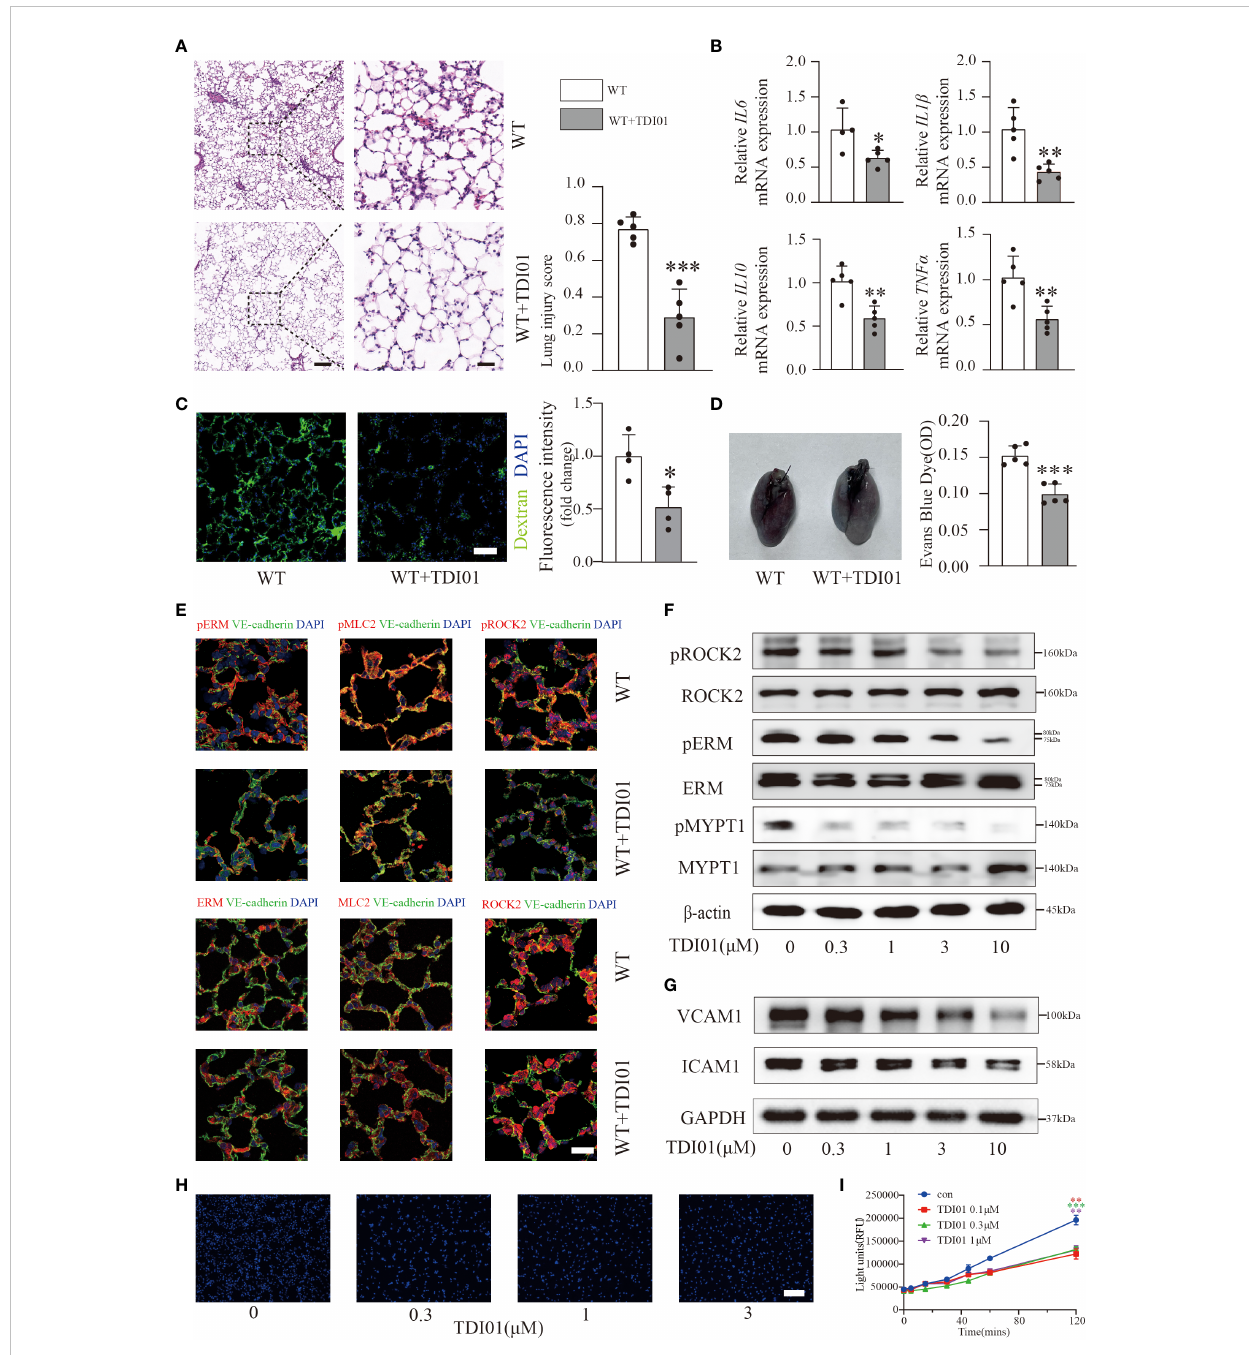
FIGURE 6 TDI01 could rescue LPS-induced ALI/ARDS and TNF a -stimulated HUVECs. Representative lung sections were stained with hematoxylin and eosin, and lung injury scores were quanti fi ed, n=5 per group. Scale bars: 200 µm (left) and 40 µm (right) (A) . The relative mRNA expression of in fl ammatory cytokines ( IL6 , IL1 b , IL10 , TNF a ) in the TDI01-pretreated WT group was reduced (B) . n=4 or 5 per group. Vascular permeability was tested by FITC- dextran (C) and EBD (D) , and TDI01 has a protective role in the vascular barrier, as evidenced by decreased extravasation of FITC-dextran (C) , n=4 per group, scale bars: 50 µm and Evans blue dye (D) , n=5 per group. Endothelial ROCK2 activity was inhibited by TDI01 in WT mice and was assessed by the colocalization of pERM/ERM, pMLC2/MLC2 and pROCK2/ROCK2 (red fl uorescent protein) with VE-cadherin (green fl uorescent protein) by immuno fl uorescent staining. Representative images are shown (E) . n=3 per group, scale bars: 20 µm. HUVECs were pretreated with 0, 0.3, 1, 3 and 10 µM of TDI01 for 24 h and then treated with 20 ng/ml of TNF a for 12 h. ROCK2 activity was examined by WB (F) . The expression of VCAM1 and ICAM1 was assessed by WB (G) . HUVECs were pretreated with TDI01 (0, 0.3, 1, 3 µM) for 24 h and then challenged by 20 ng/ml of TNF a for 12 h. Hoechst 33342-labeled monocytes were added to each well and co-incubated for 4 h. Representative images of adhered Hoechst 33342- labeled monocytes are shown (H) . n=3 per group, scale bars: 200 µm. HUVECs were pretreated with TDI01 (0, 0.1,0.3,1 µM) for 24 h, stimulated with TNF a (20 ng/ml) for 12 h and then plated for permeability assay. The fl uorescence intensity of FITC-dextran was recorded at 0, 5, 15, 30, 45, 60, 120 min (I) . n=3 per group. Each bar represents the mean ± SD; *p < 0.05, **p < 0.01 and ***p <